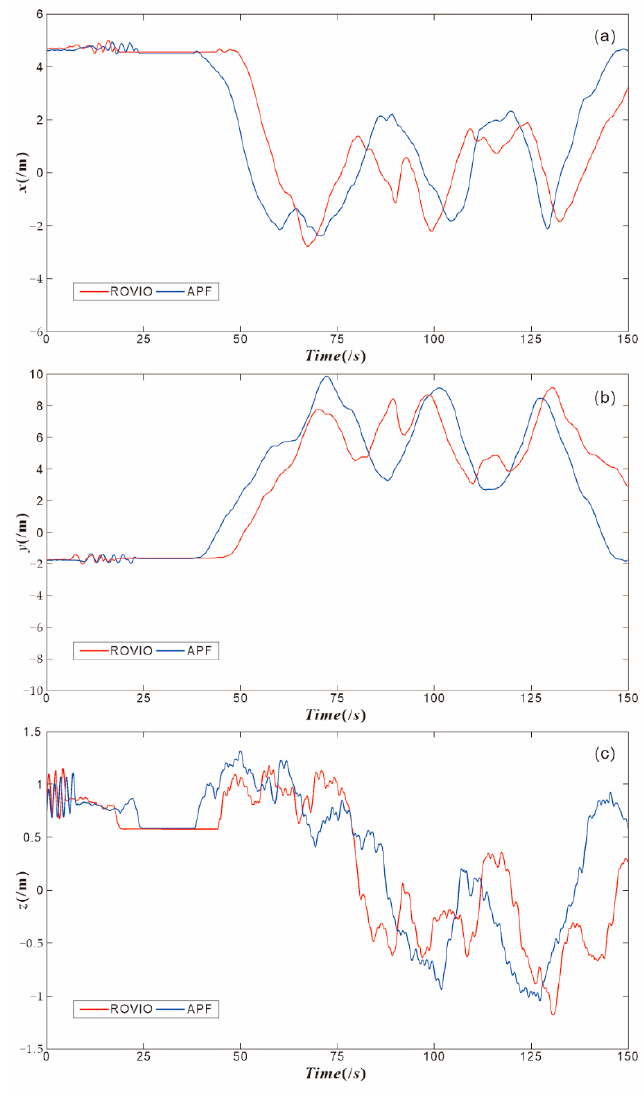
Figure 9. Displacement deviation along the x -axis ( a ), y -axis ( b ) and z -axis ( c ) direction. Comparing the proposed algorithm with the ROVIO algorithm shows that the abso- lute RMSE is 2.5944 m, and the absolute standard deviation error is 1.5223 m (Table 4). We